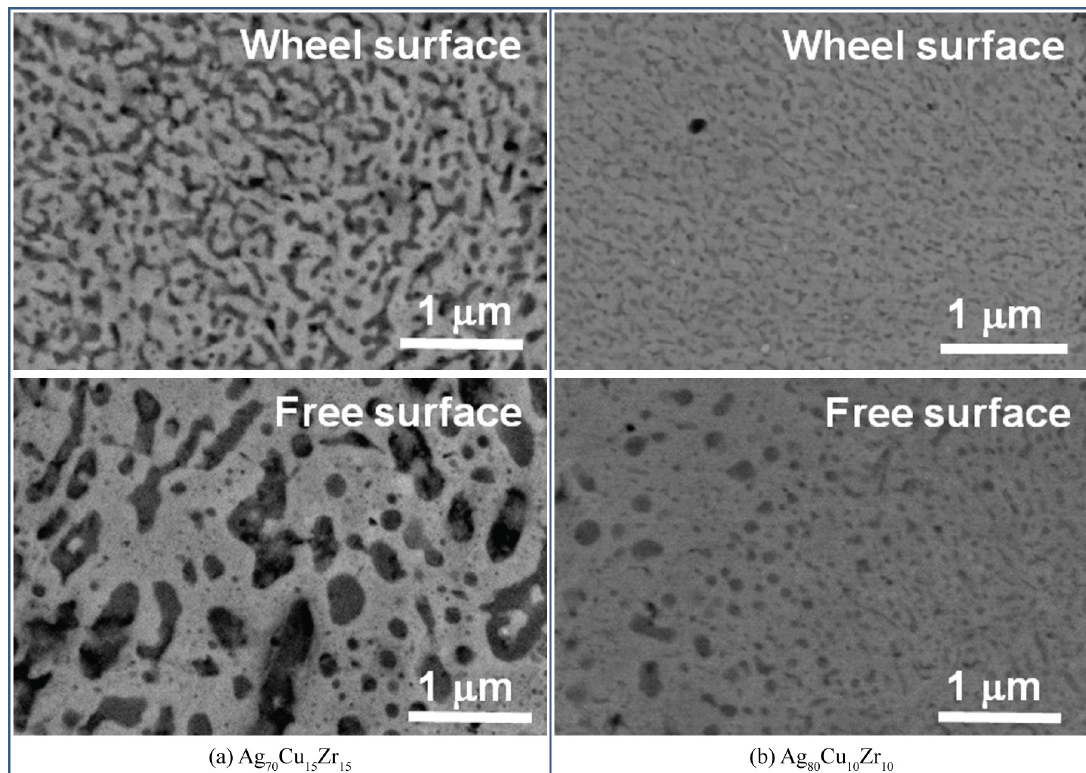
Figure 4. SEM image of the melt-spun ribbons. (a) Ag